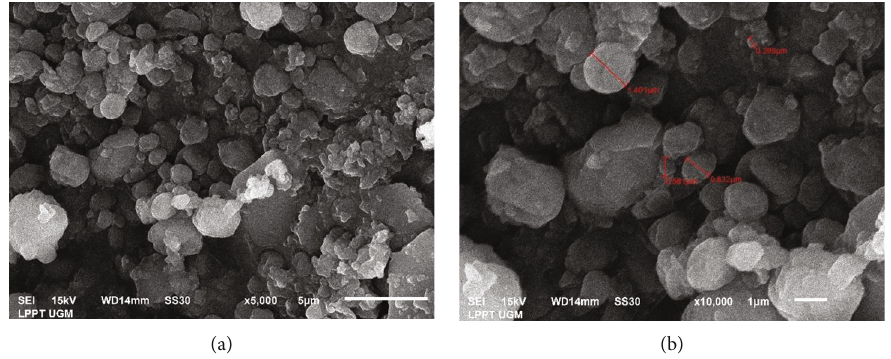
Figure 5: SEM image for sa ff ron essential oil nanoparticles: (a) 5000x; (b) 10.000x.